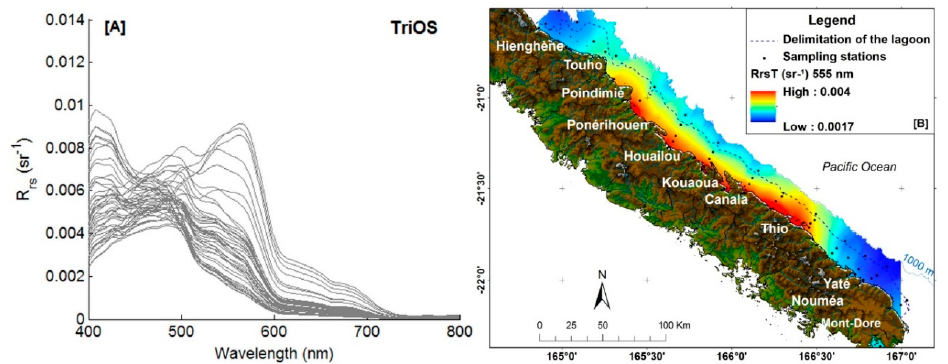
Figure 8. In situ remote sensing reflectance ( R rs ) spectra obtained with the TriOS sensor ( A ) and the surface distribution map of R rs (555) ( B ) (Number of samples = 48).